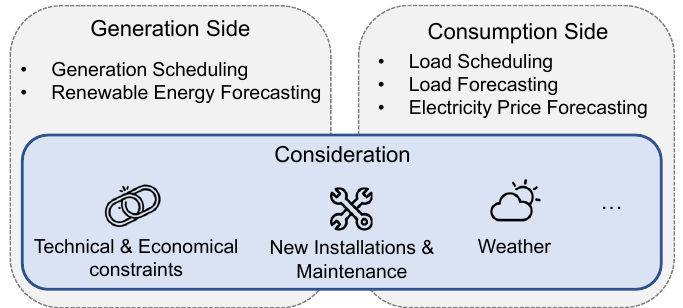
Figure 7. Scheduling and